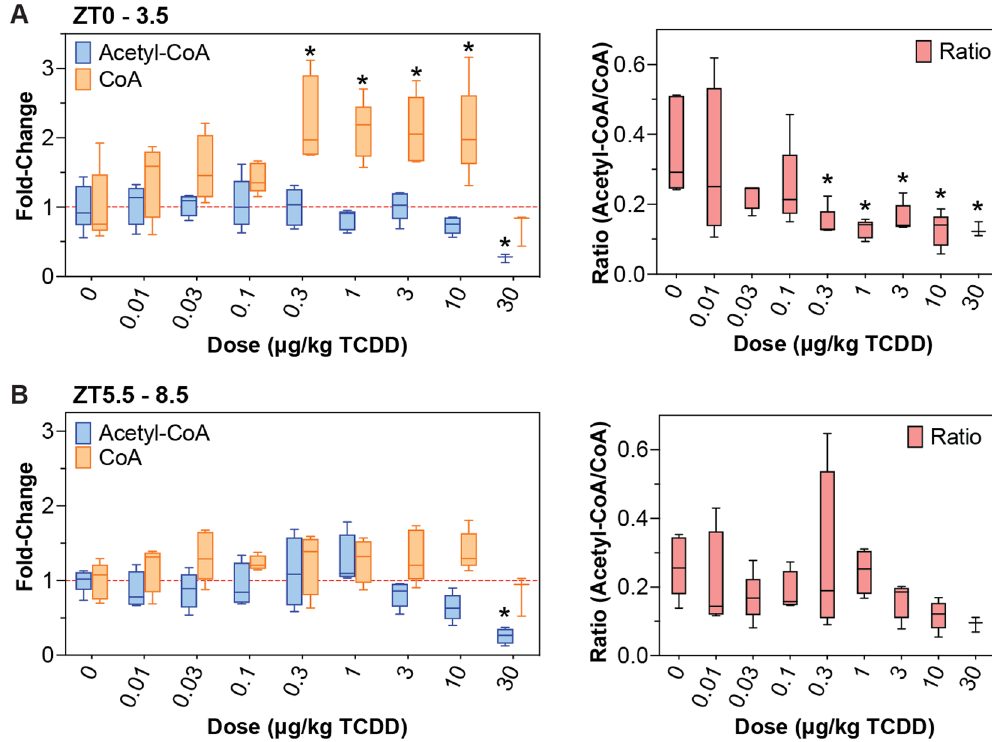
Figure 1. Hepatic acetyl-CoA and coenzyme A (CoA) levels assessed in mice using targeted liquid chromatography tandem mass spectrometry. Mice were gavaged with TCDD (or sesame oil vehicle)